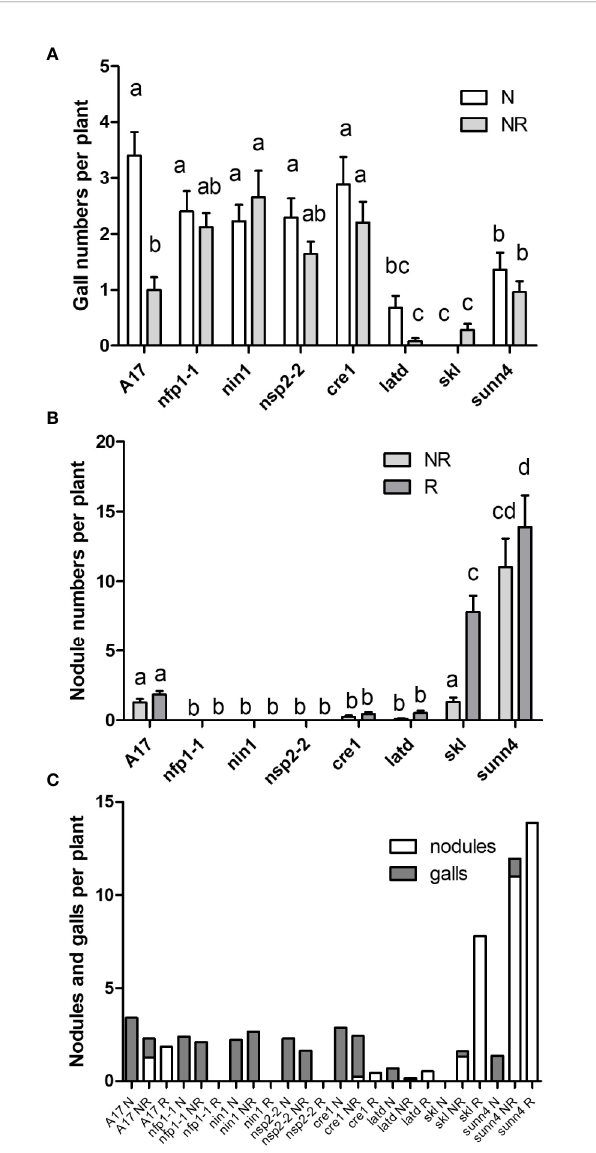
FIGURE 3 | Nematode infection phenotypes of Medicago truncatula wild type roots infected with J2s hatched from eggs harvested from different nodulation mutants. (A) Number of galls per plant. No signi fi cant differences were found between egg origin from different genotypes. (B) Number of egg masses per plant. N = 14 – 21 plants for each genotype. Graphs show means and standard errors. Means with different letters differ signi fi cantly from each other with p < 0.05 (one-way ANOVA with Tukey ’ s post-test).